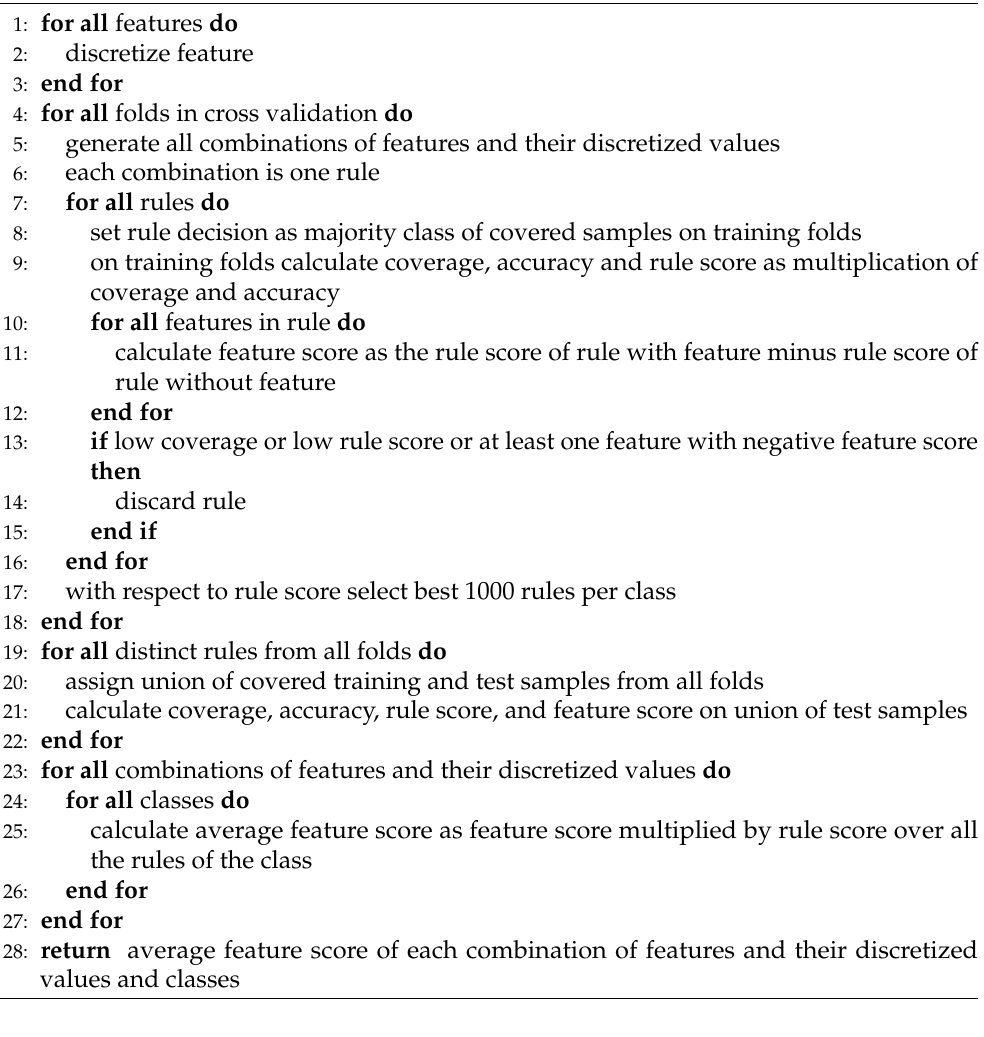
Algorithm 1 Pseudo-code of the Rule discovery